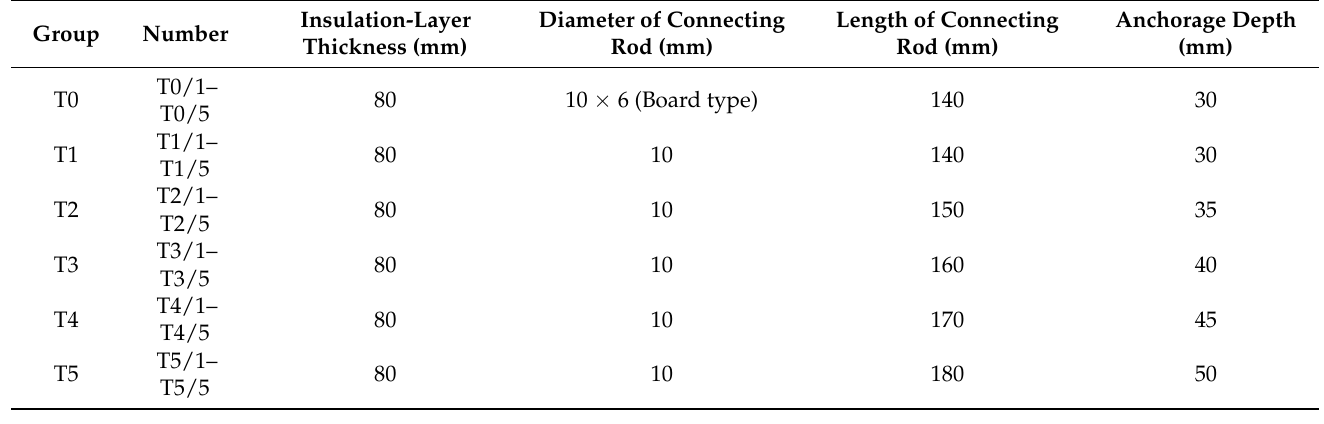
Table 3. Parameters of the pull-out-test specimen.